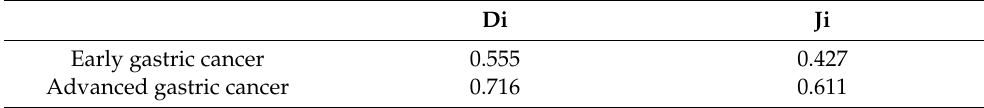
Table 3. Evaluation results of cancer